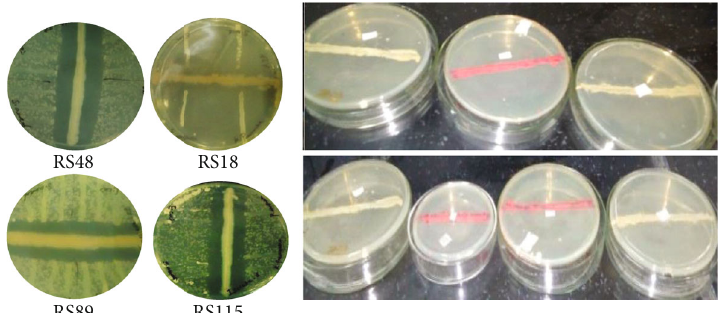
Figure 3: Primary screening of Streptomyces isolates for antibacterial compound production against bacterial strains using the perpendicular streak plate method.